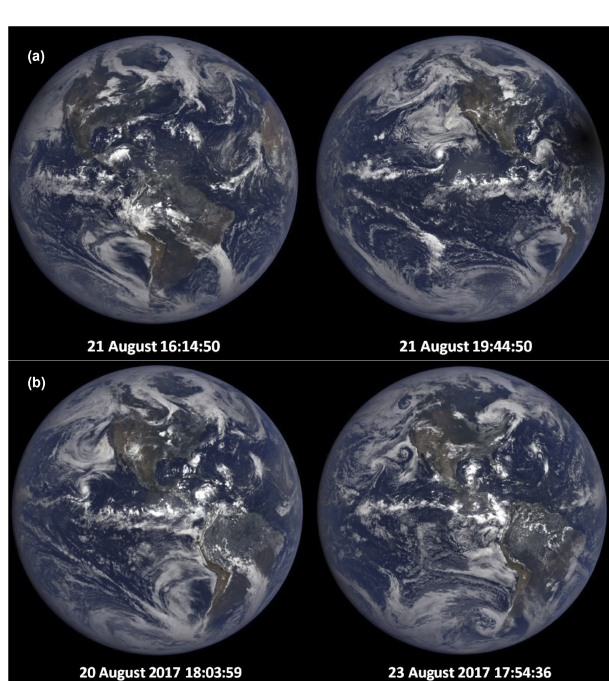
and 19:44 before and after the eclipse over the US, and (b) the days before and after the eclipse selected to be as close as possible to the phase angle (UTC 17:44:50) as the time of totality over Casper, Wyoming. North is facing